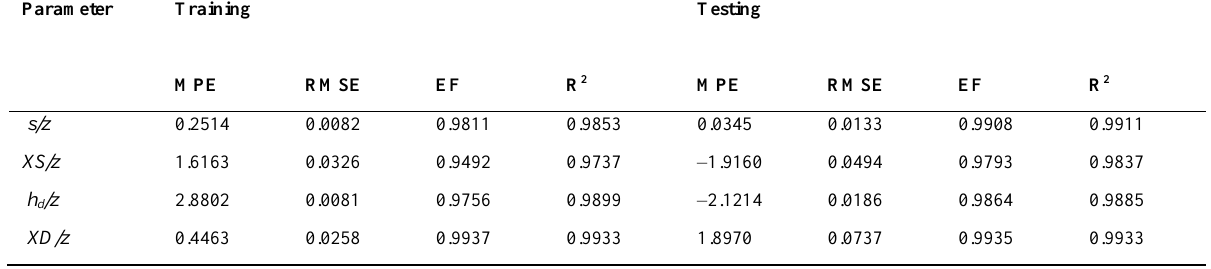
Table 6. Statistical error functions of ANN for estimating scour hole dimensions for best network architecture Parameter Training